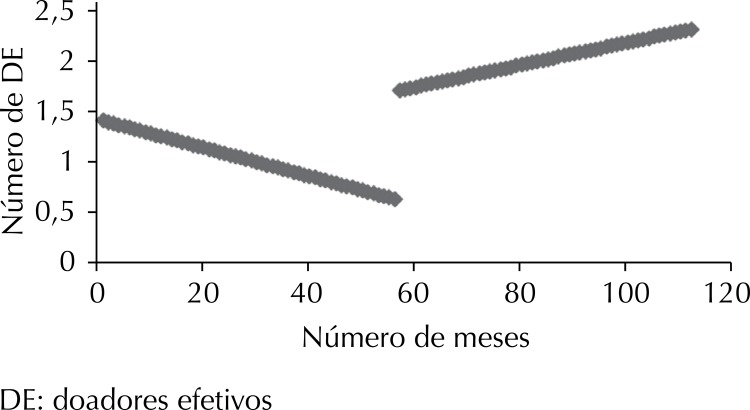
Número de doadores efetivos antes e depois do projeto no Hospital 1. São Paulo, 2003 a 2012.